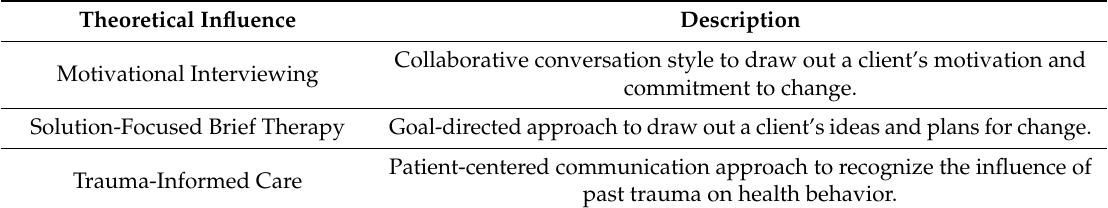
Table 1. Theoretical influences for the Technology Enhanced Screening and Supportive Assistance (TESSA) health advocacy